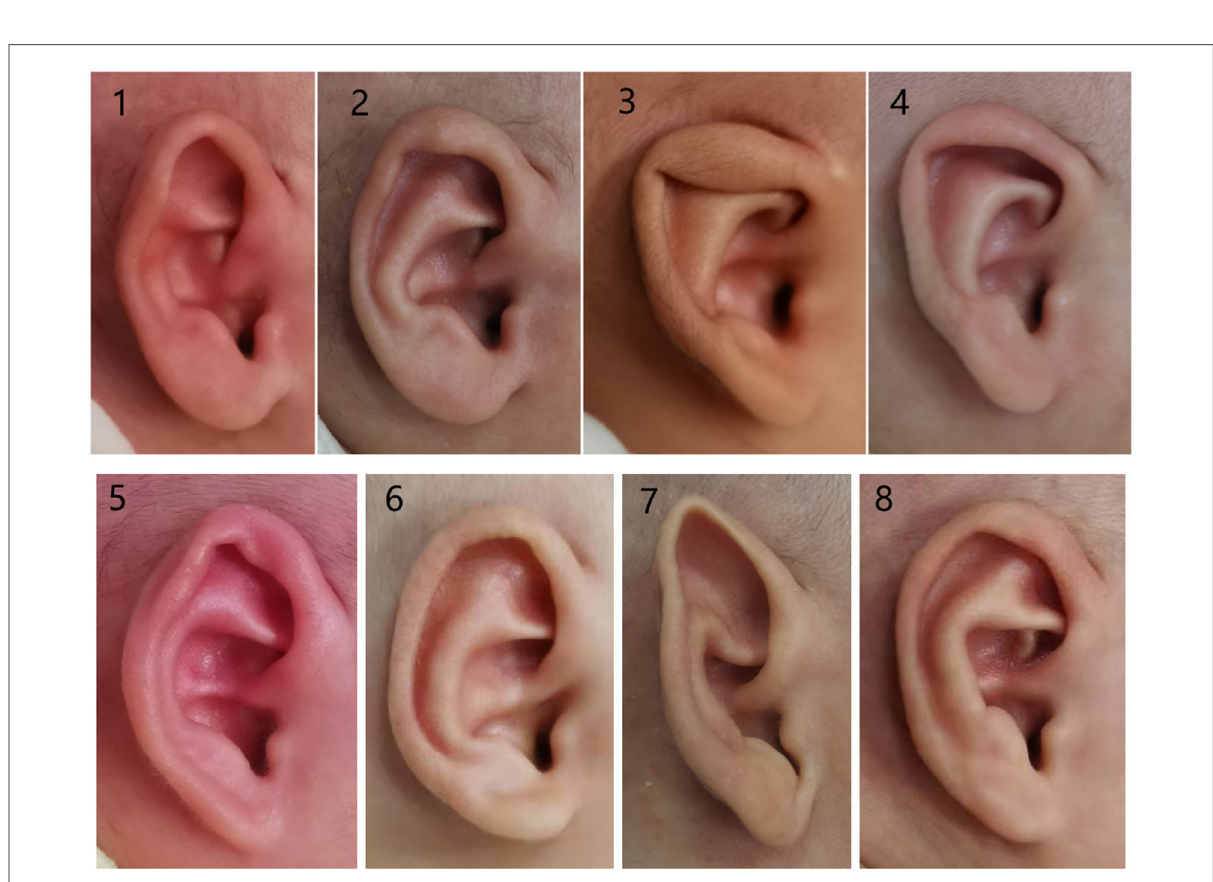
FIGURE 3 Photographs of congenital ear deformities before and after treatment (part I): (1 and 2) before and after treatment of the prominent ear, (3 and 4) before and after treatment of the lidding ear, (5 and 6) before and after treatment of the helical rim abnormality, and (7 and 8) before and after treatment of Stahl ’ s